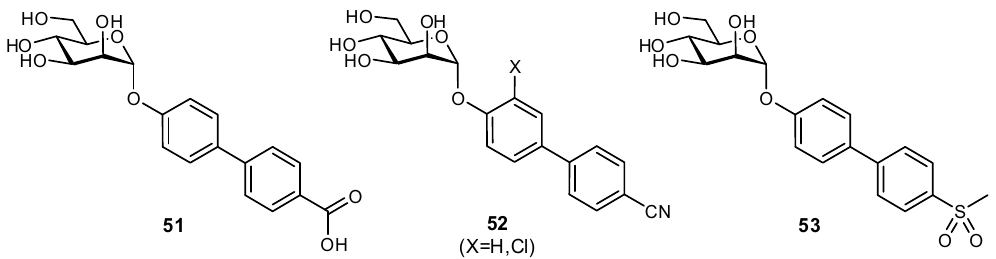
Figure 17. Bioisosteric replacement of a carboxylate moiety was used to optimize FimH antagonist 51 which suffered from rapid renal clearance and low tubular reabsorption in vivo [128].